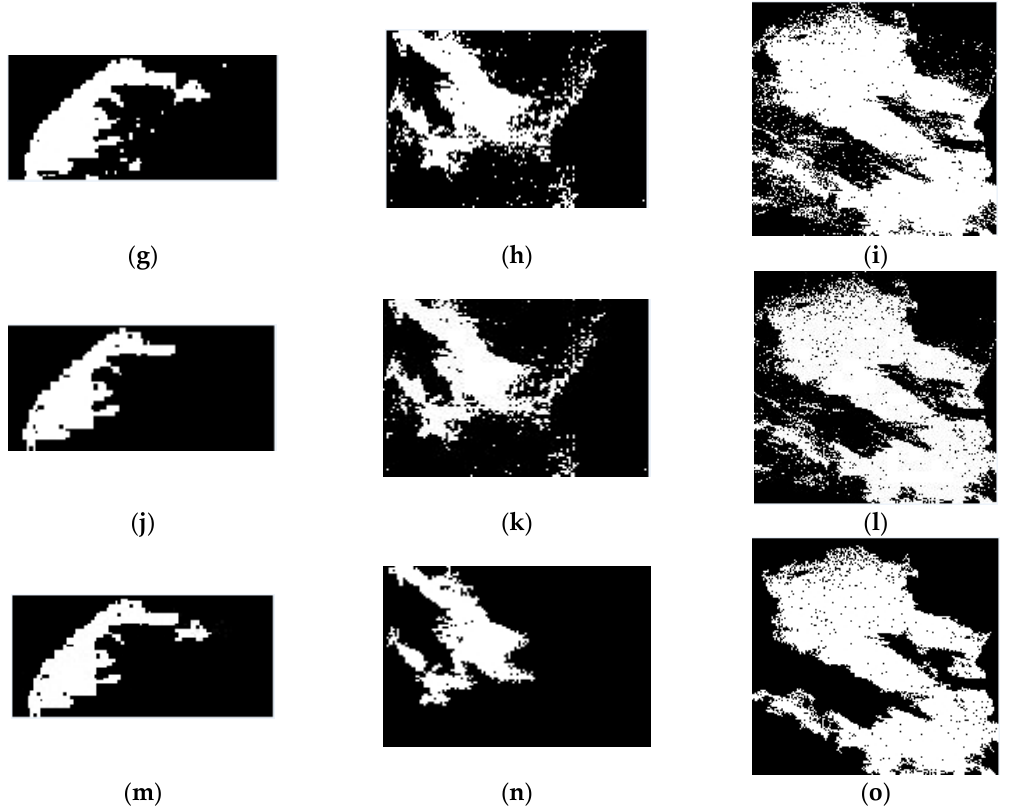
Figure 11. Dark region segmentation results: ( a , b ) are manually cropped dark regions of Taihu Lake SAR image; ( c ) is that of Chaohu Lake SAR image; ( d – f ) are the segmented dark regions of ( a – c ); ( g – i ) are obtained by the traditional K-means algorithm; ( j – l ) are obtained by the multi-Otsu thresholding algorithm; ( m – o ) are obtained by the method proposed in this paper.